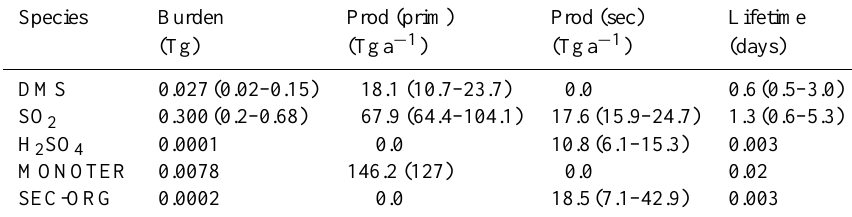
Table 4. Annual mean global mass burden, production fluxes and lifetime for each simulated aerosol precursor gas. For the sulfur species the mass is of sulfur (multiply by 1.94, 2, 3.06 for mass of DMS, SO 2 and H 2 SO 4 , respectively), whereas for the organic species the mass is of carbon (multiply by 11.3 and 12.5 for mass of terpenes and condensable organic). The range shown in parentheses for DMS and SO 2 are based on the literature values listed in Spracklen et al. (2005) except for the DMS conversion to SO 2 which is based on the DMS oxidation fluxes to SO 2 from Boucher et al. (2003) using a range of DMS climatologies, oxidant fields and sea-air transfer functions. For terpenes, the emissions total from Guenther et al. (1995) is shown in parentheses for reference. The (10–60TgPOM/yr) range of SOA production quoted in Dentener et al. (2006) is also shown for reference. Species Burden Prod